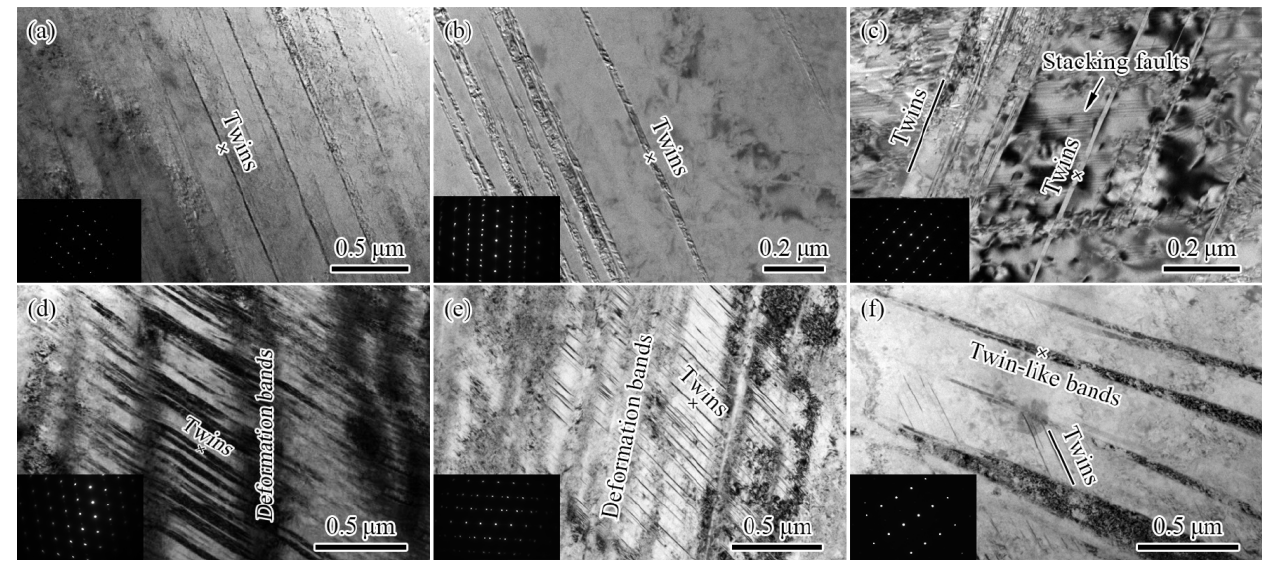
Figure 4. TEM images showing the deformation microstructures in Fe-19Cr-16Mn-2Mo-0.49N steel at the strain rates of 10 − 2 s − 1 ( a – c ) and 10 − 4 s − 1 ( d – f ). Note that the inset in ( a – f ) is the selected area diffraction pattern (SADP).